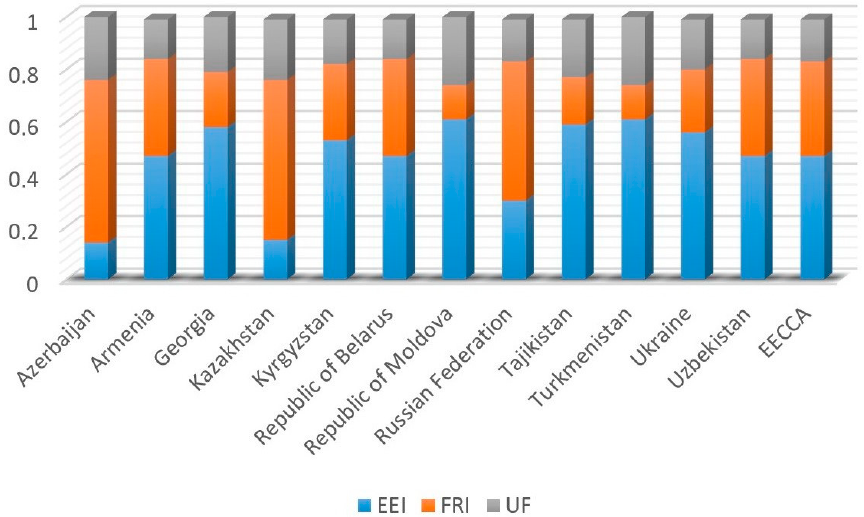
Figure 5. The influence of financial risk and energy efficiency indicators on the level of energy sup- ply to socially vulnerable groups of the population of the EECCA countries. Source: authors’ elabo-